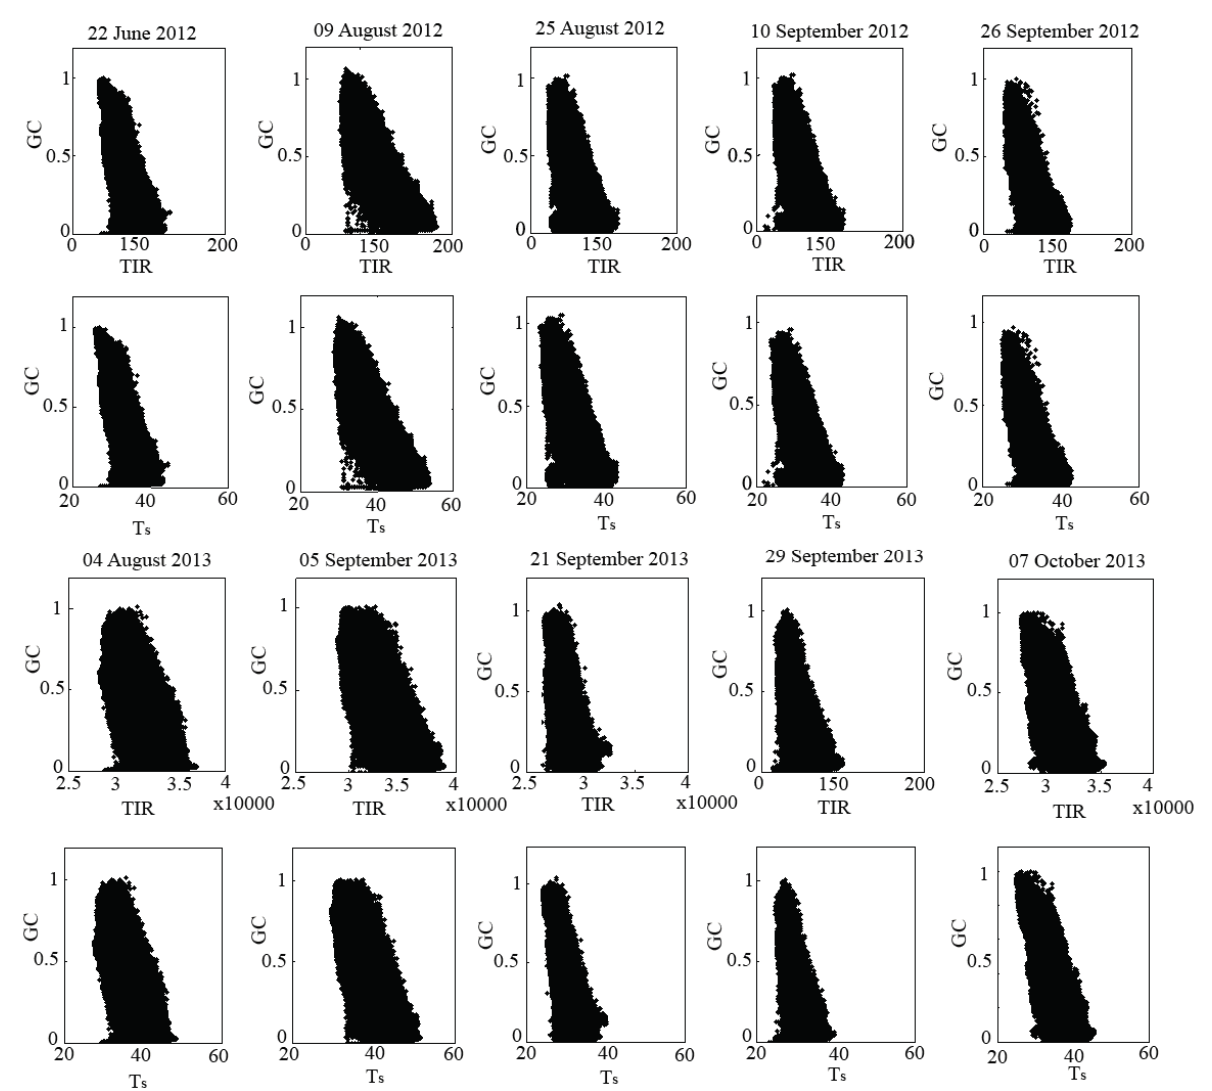
Figure 5. Plots of GC values vs. TIR values for each image acquisition, along with corresponding plots of GC vs. T s